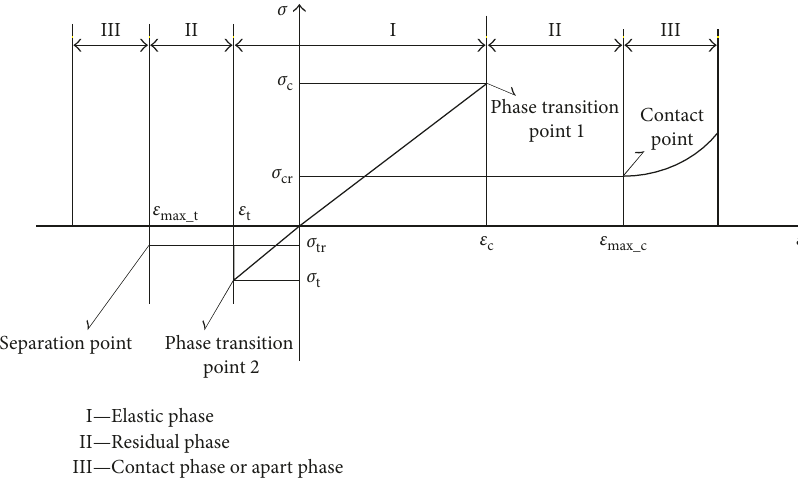
Figure 4: Primitive phase